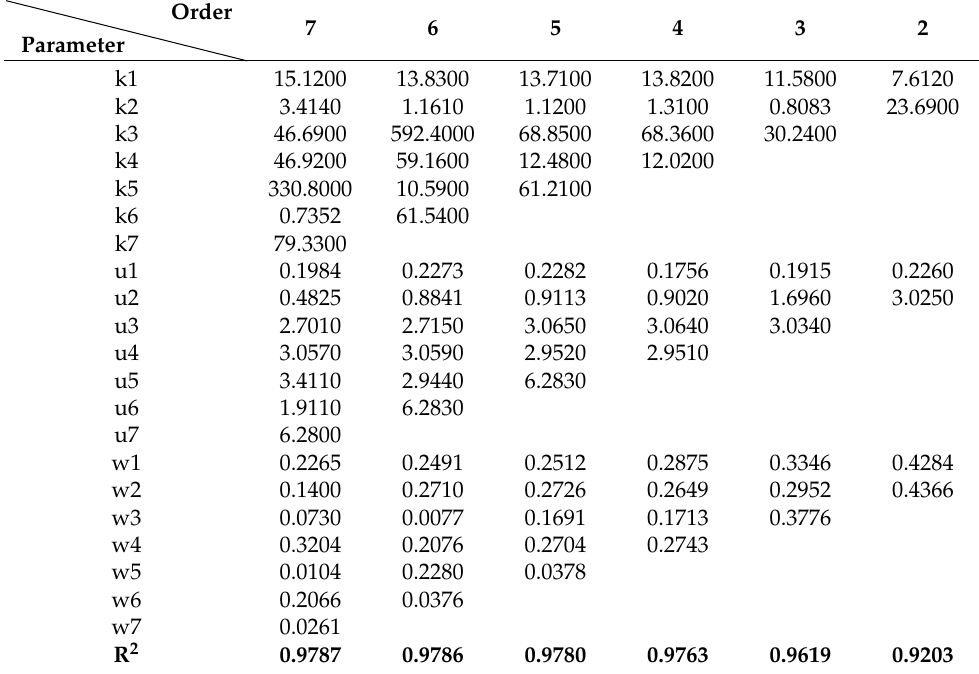
Table 5. Results and effects of each order fitting parameter at 30 m height.